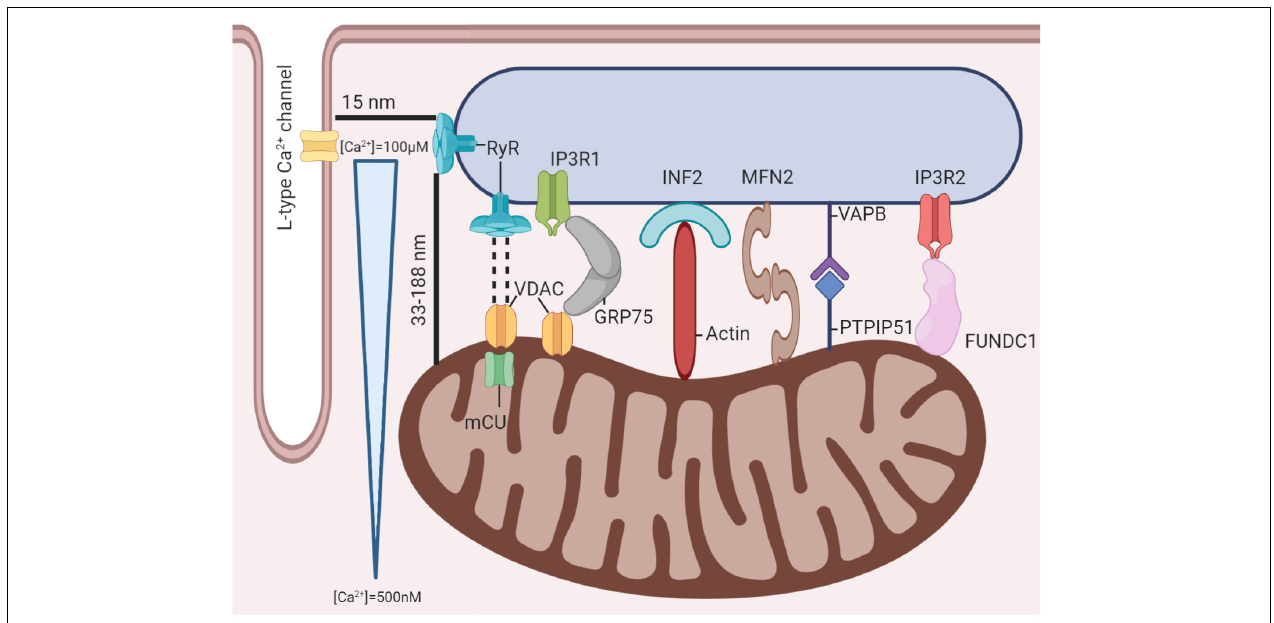
FIGURE 1 | Mitochondria-SR-T tubule microdomain. Several protein structures have been demonstrated to exist between mitochondria and the SR. These structures maintain proximity between the organelles and enable mitochondria to experience significant Ca 2 + fluctuations with each AP despite the global cardiomyocyte’s Ca 2 + concentration remaining relatively